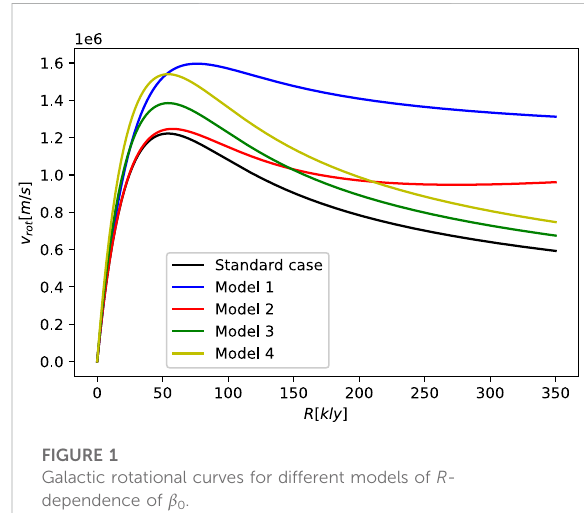
FIGURE 1 Galactic rotational curves for different models of R - dependence of β 0